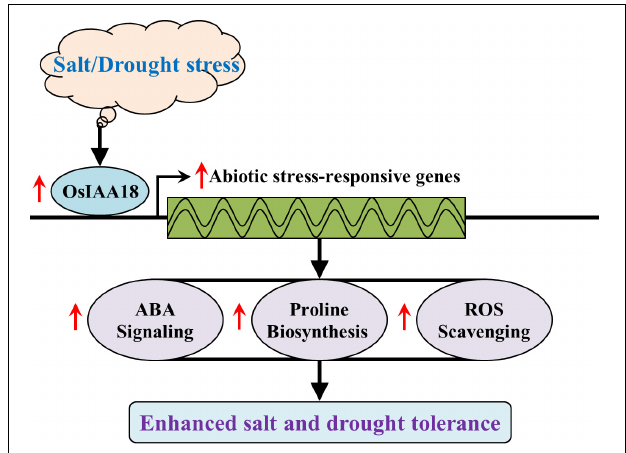
FIGURE 9 | A proposed model explaining the function of OsIAA18 in response to salt and drought stresses. Under salt and drought stresses, the overexpression of OsIAA18 upregulated the expression of abiotic stress-responsive genes involved in ABA signaling, proline biosynthesis, and ROS scavenging, leading to increased ABA sensitivity to exogenous ABA and proline accumulation, finally enhancing salt and drought